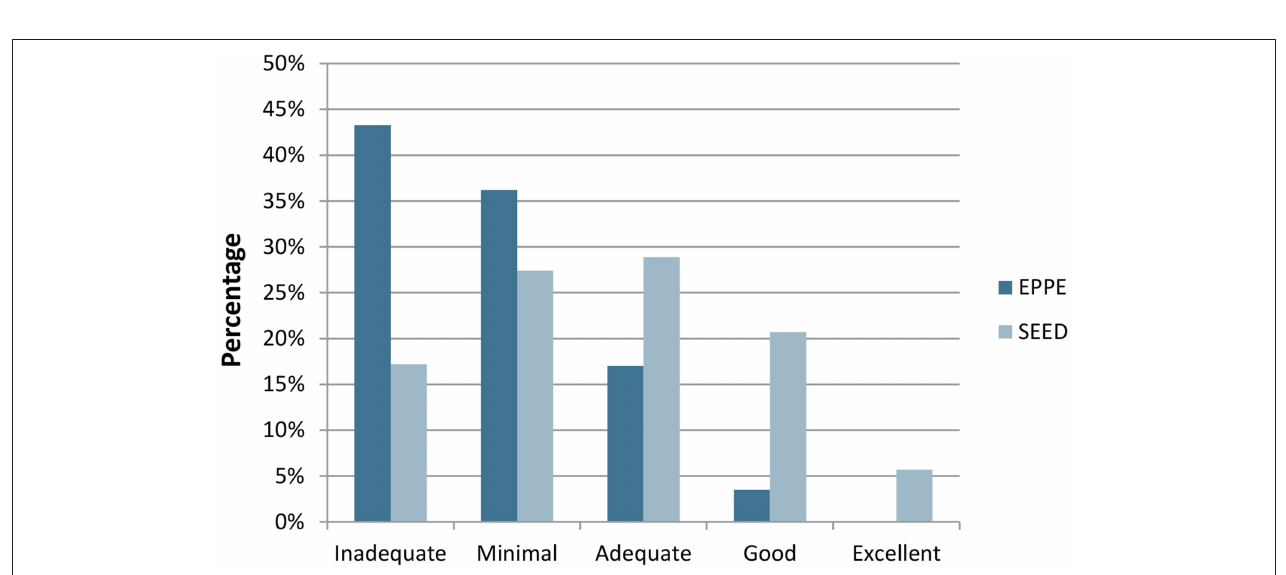
FIGURE 1 | Percentage breakdown of ECERS-R scores by quality level in the EPPE and SEED studies. Quality is classified as Inadequate ( < 3), minimal ( ≥ 3 and < 4), adequate ( ≥ 4 and < 5), good ( ≥ 5 and < 6) or excellent ( ≥ 6). Figure © 2017 NatCen Social Research, University of Oxford and Action for Children, reproduced with permission.